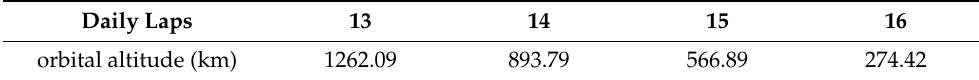
Table 1. Correspondence between daily laps and orbital altitude of satellites. Daily Laps 13 orbital altitude (km)